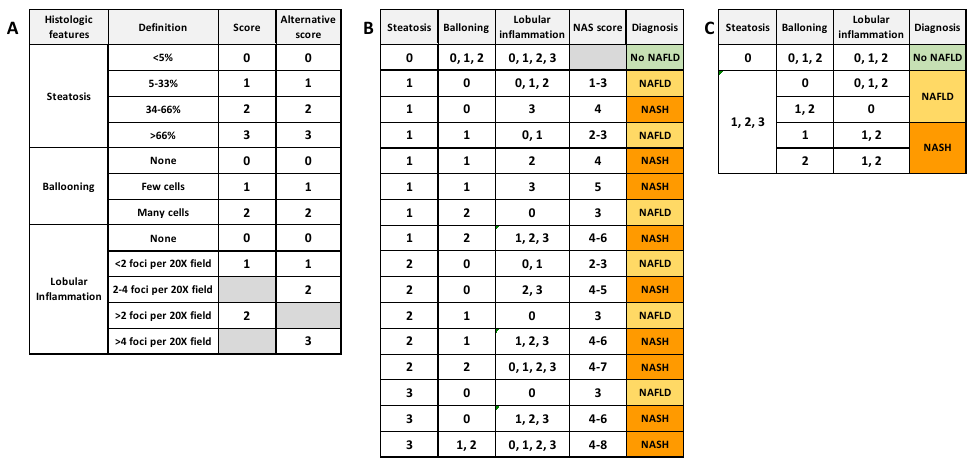
Figure 2. Common algorithms for NAFLD and NASH scoring. ( A ): semiquantitative histology scoring for each histologic feature. ( B ): Diagnosis algorithm based on NAS score (NASH if NAS score ≥ 4) [14]. ( C ): Diagnosis algorithm based on unweighted histologic features (NASH if all features present, whatever the score) [15].